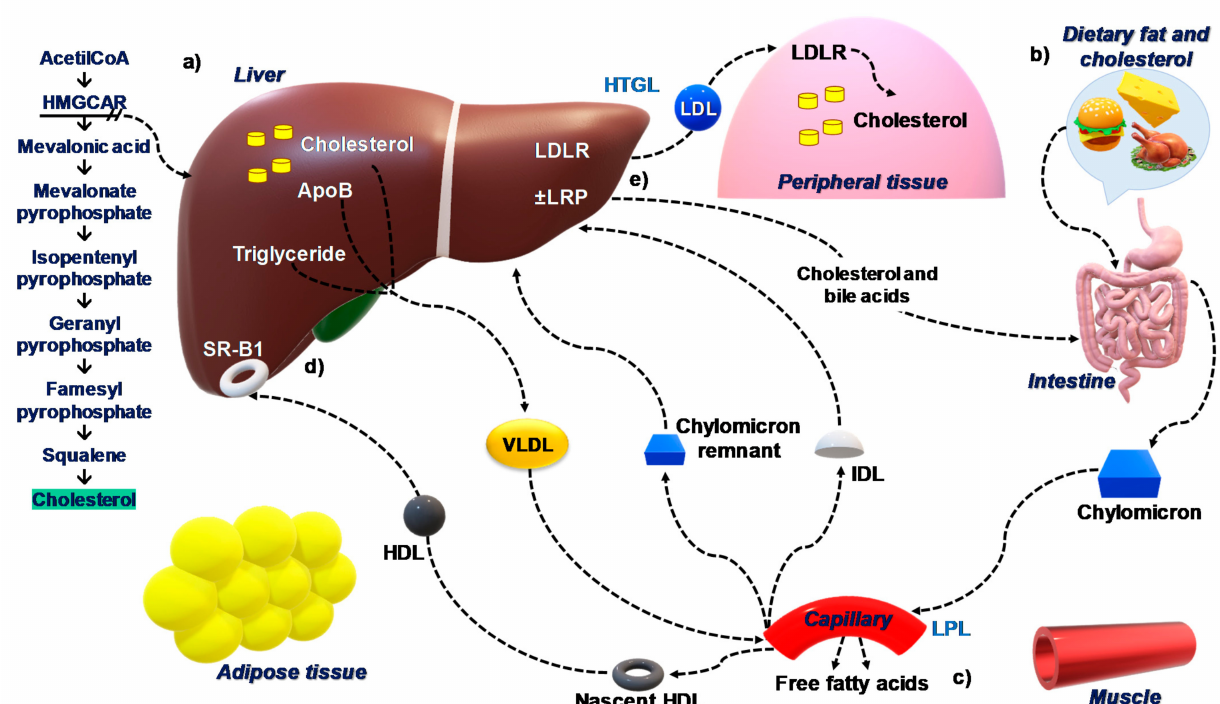
Figure 1. Cholesterol homeostasis in the body. ( a ) The rate of cholesterol synthesis by the liver is highly dependent on the cellular level of cholesterol and the absorption rate of the small intestine. This feedback regulation is determined predominantly by sterol regulatory element-binding protein-2 (SREBP-2). Subsequently, 3-hydroxy-3-methylglutaryl coenzyme A reductase (HMGCR) catalyzes the formation of mevalonate, the rate-limiting step in cholesterol biosynthesis. ( b ) Cholesterol and triglycerides from diets are absorbed in the small intestine and are incorporated into chylomicrons. ( c ) In the plasma, lipoprotein lipase (LPL) acts on chylomicrons to generate fatty acids and chylomicron remnants that are taken up by the liver. The nascent HDL is generated by lipolysis mediated by LPL of lipoproteins rich in triglycerides including VLDL. ( d ) The concentration of free cholesterol is ”sensed” by SREBP-2 that activates cholesterol synthesis enzyme, HMGCR, when cholesterol content in the hepatocytes is reduced by the import of lipoproteins or is increased by the conversion to bile acids. In addition, SREBP-2 also activates the synthesis of LDL receptors (LDLR), accelerating the uptake of cholesterol from LDL and then promoting the storage of cholesterol in the liver. ( e ) Conversely, when cholesterol content in the hepatocytes is increased, SREBP-2 is inhibited, leading to LDLR downregulation and inactivation of cholesterol synthesis. Abbreviations: LDLR, low-density lipoprotein receptor; HMGCR, 3-hydroxy-3-methylglutaryl coenzyme A reductase; VLDL, very low-density lipoprotein; HDL-C, low high-density lipoprotein-cholesterol; LPL, lipoprotein lipase; SREBP-2, sterol regulatory element-binding